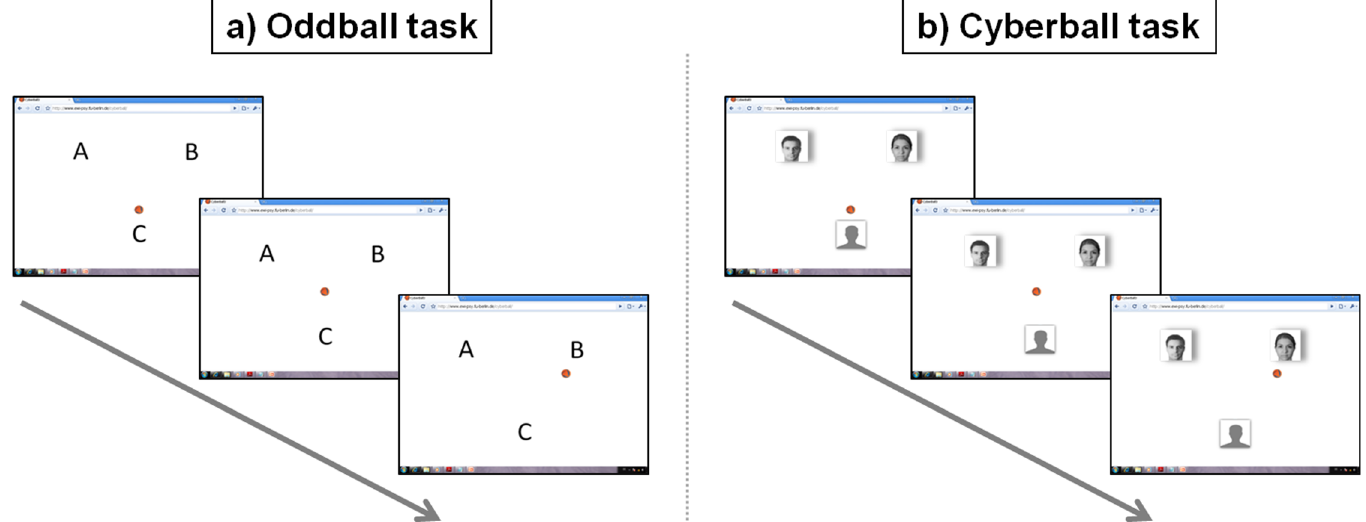
Fig 1. Display of the visual Oddball (a) and the Cyberball (b) task. The events “ circle at position ‘ C ’” (Oddball) or “ ball possession of the participant ” (Cyberball) were defined as target events, since they required the participant to press a button to move the circle/ball to the position “ A ” or “ B ” or to the left or right co-player. Before the circle/ball appeared at the selected position, it remained at the center of the screen for 500 ms. At the positions “ A ” or “ B ” or at one of the co-players ’ position (non-target events) the circle/ball remained for 400 to 1400 ms, and the participant was not required to react. Note that the pictures of the presumed co-players (b) were no real photos, but morphs of different